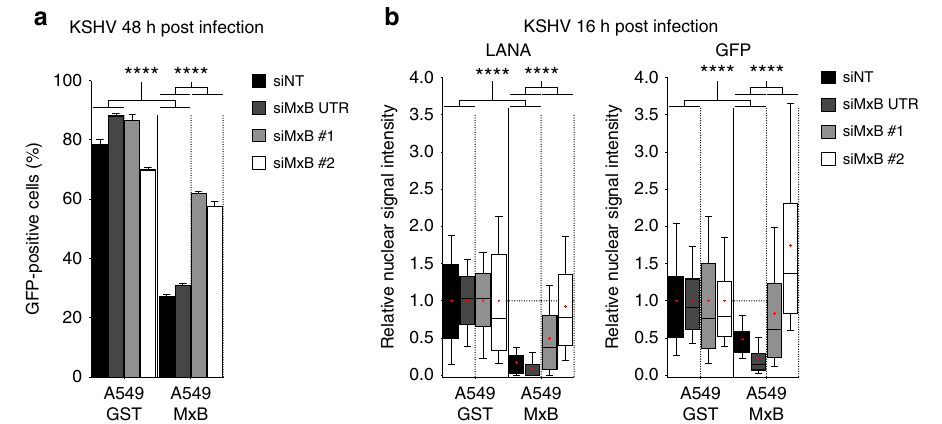
Fig. 3 Ectopic expression of MxB inhibits KSHV latent infection and protein expression. a A549-GST and A549-MxB cells were transfected with the indicated siRNAs. At 48 h post transfection, cells were infected with recombinant KSHV expressing GFP (MOI = 0.5) for 48 h. Viral output was measured by fl ow cytometry. Data are representative of three independent experiments. Bars indicate mean ± s.d., n = 3 biological replicates. ANOVA modelling arcsine-transformed fraction of GFP-positive cells with cell line and siRNA as explanatory variables: cell line, F (1,16) = 3920.2, p < 0.0001; siRNA, F (3,16) = 227.1, p < 0.0001; antagonising interaction, F (3,16) = 325.2, p < 0.0001. b A549-GST and A549-MxB cells were transfected as in a , but then infected with recombinant KSHV expressing GFP (MOI = 0.5) for 16 h. Intranuclear levels of endogenous latency-associated nuclear antigen (LANA, left panel) and GFP reporter (right panel) were measured using immuno fl uorescence assay. Data are representative of two independent experiments, showing nuclear signal intensity in A549-MxB cells relative to A549-GST cells for each group. Boxes depict median, 25th and 75th percentile with mean marked with a ‘ + ’ . Whiskers denote the 10th and 90th percentile. For each comparison, 354 cells were randomly selected. ANOVAs modelling log-transformed relative signal intensity with cell line and siRNA as explanatory variables: LANA: cell line, F (1,2824) = 1283.6, p < 0.0001; siRNA, F (3,2824) = 152.4, p < 0.0001; antagonising interaction, F (3,2824) = 218.5, p < 0.0001. GFP: cell line, F (1,2824) = 300.4, p < 0.0001; siRNA, F (3,2824) = 225.5, p < 0.0001; antagonising interaction, F (3,2824) = 256, p < 0.0001. Multiple comparisons: **** p <